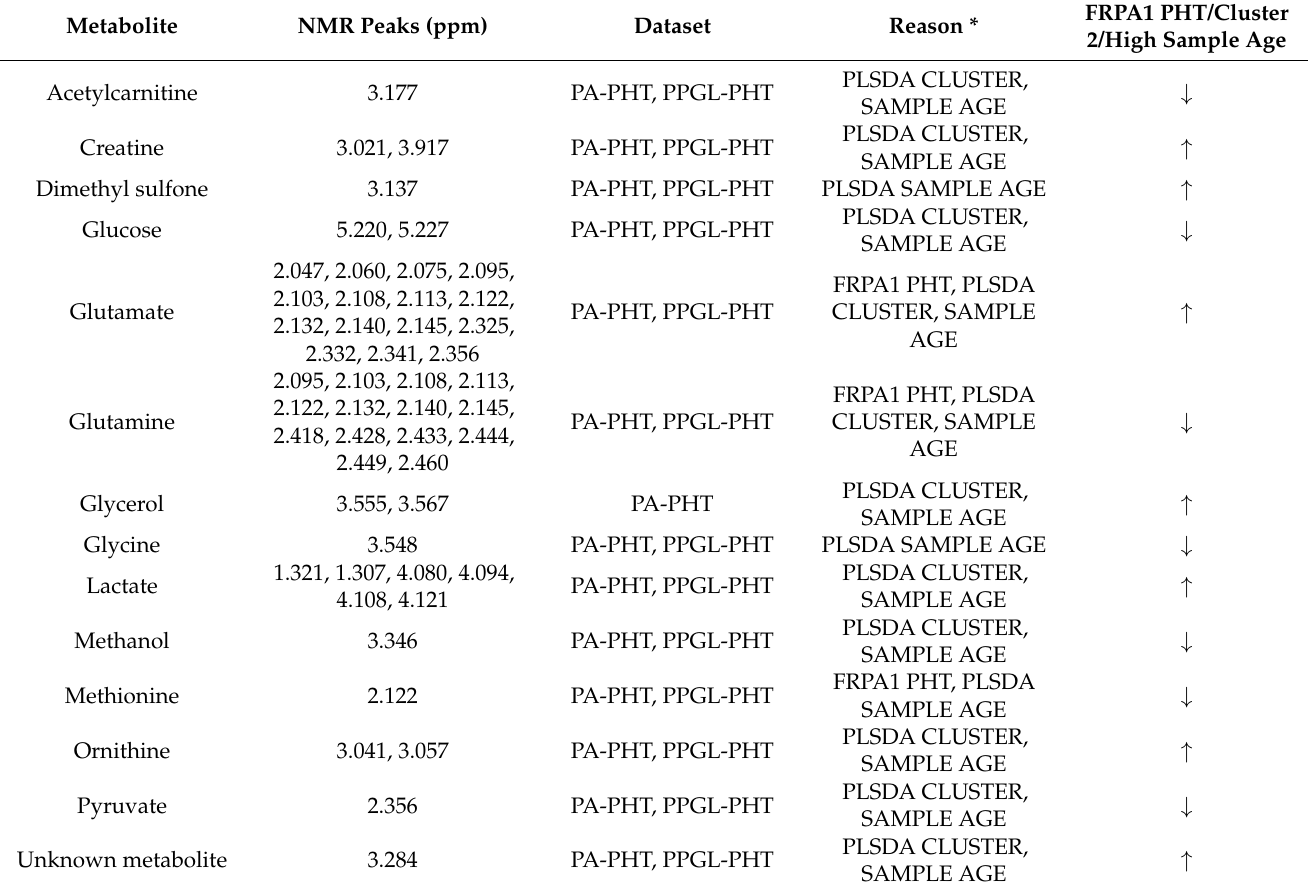
Table 4. Metabolites selected for exclusion due to a strong relationship with a